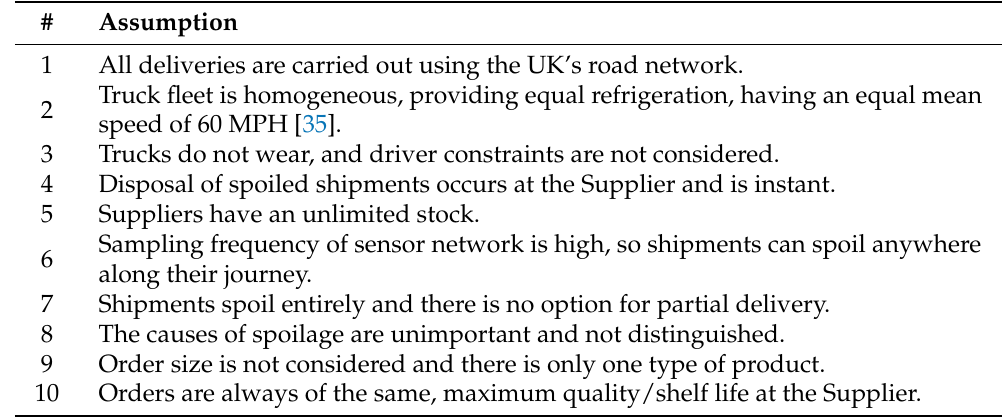
Table 4. Assumptions made in order to model the supply